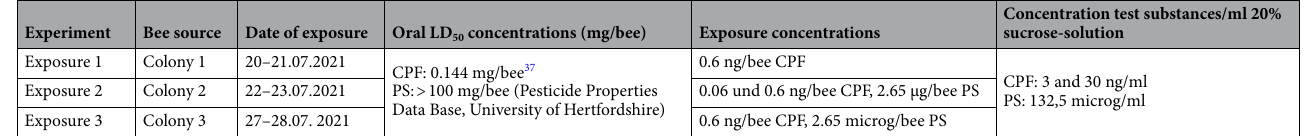
Table 2. Information on the exposure experiments and oral LD50 concentrations, CPF chlorpyrifos, PS pyraclostrobin; both test substances were dissolved in DMSO, DMSO concentration in 20%